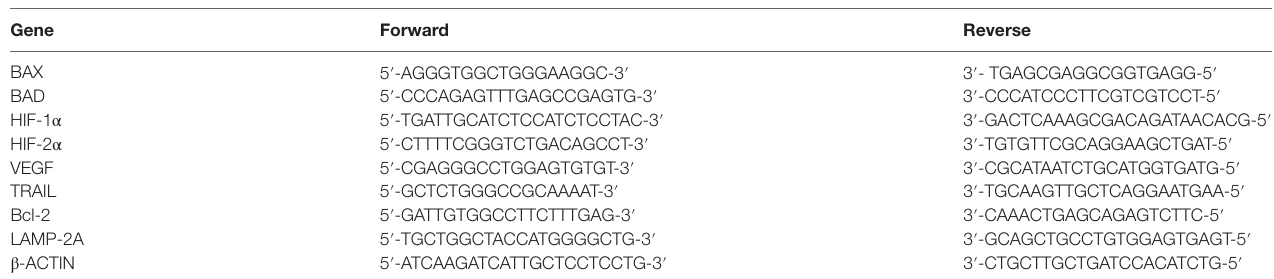
TaBle 2 | Primer sequences.